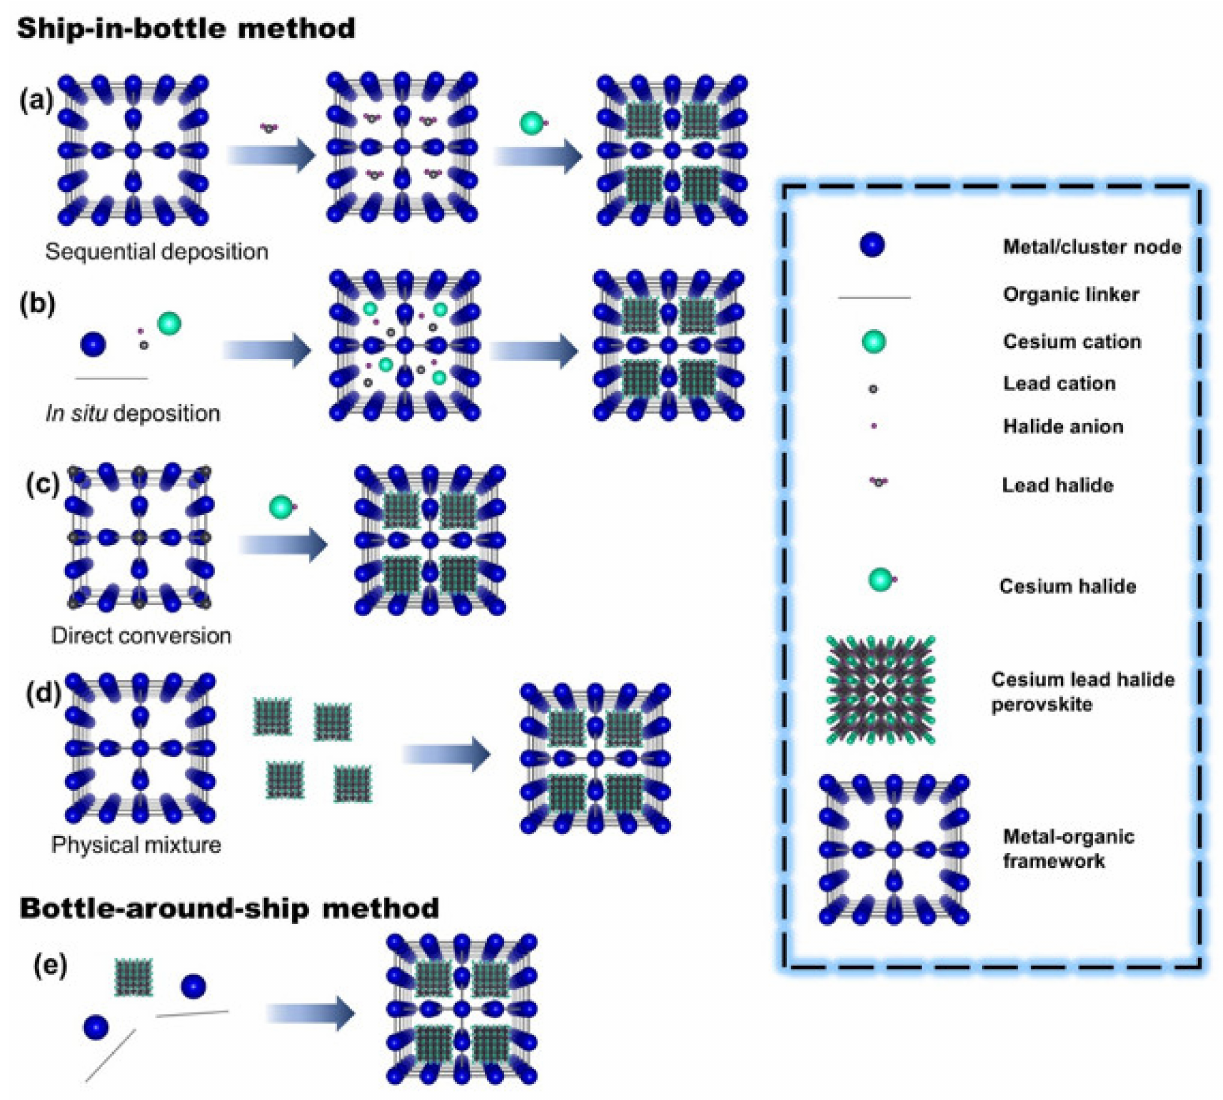
Figure 2. Synthesis methodologies for preparing MHP@MOF composites: ( a – d ) ship-in-bottle methods including sequential deposition, in situ deposition, direct conversion, and physical mixture, and ( e ) bottle-around-ship